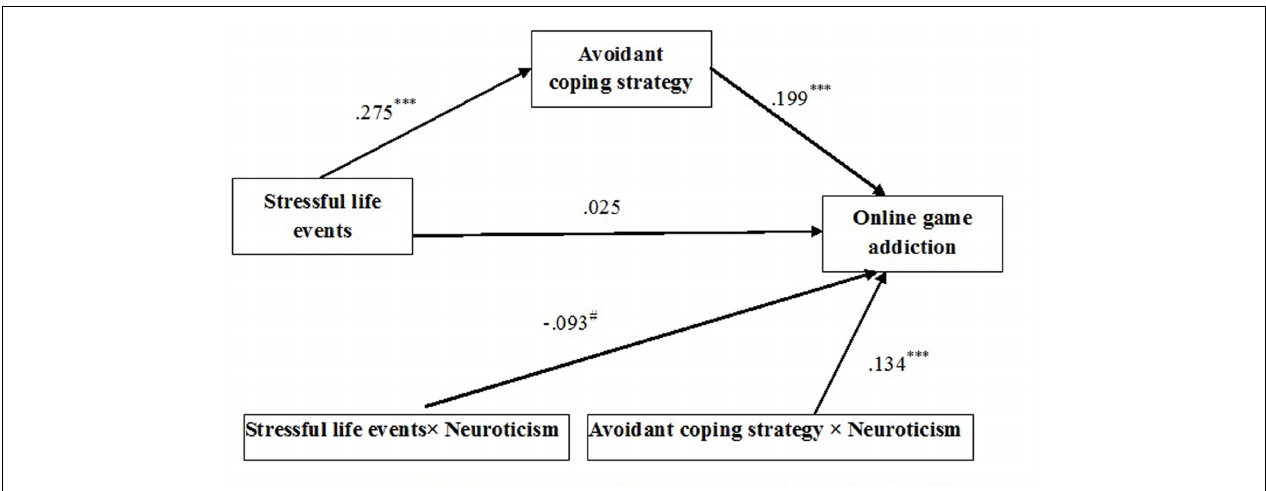
FIGURE 2 | Results of mediation analysis for online game addiction. Values presented are standardized coefficients ( ∗∗∗ P < 0.00; # P at a marginally significant level).